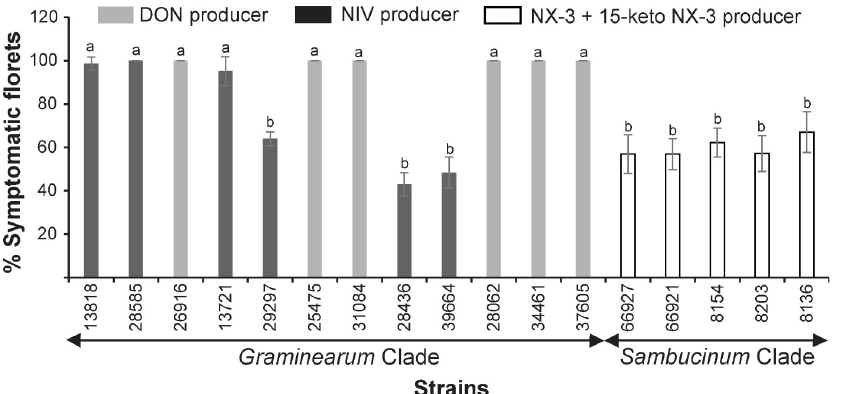
Fig 3. Fusarium head blight spread in Apogee wheat heads inoculated with strains from Graminearum and Sambucinum Clades. Percentage of symptomatic spikelets ( ± SEM) was calculated from the average of percent diseased florets in the five inoculated wheat heads 21 days post inoculation. Letters above bars indicate significant differences as determined by ANOVA analysis followed by Fisher’s protected least significant difference (LSD) test for individual comparisons (P < 0.05). Strains represented by four- and five-digit numbers were obtained, respectively, from the FRC and NRRL culture collections (strain identity and history can be found in Table